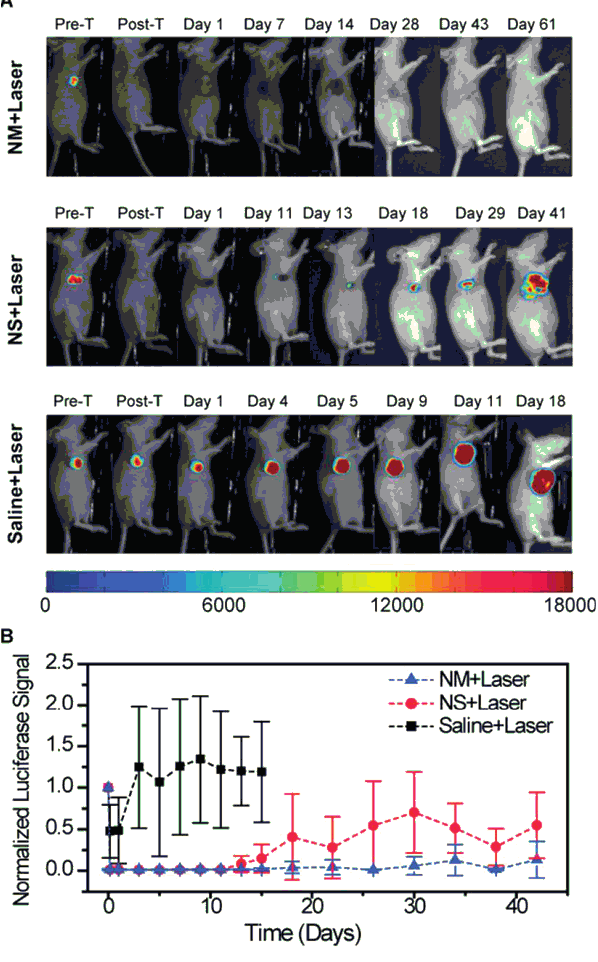
Figure 4. Evaluation of tumor response to photothermal therapy by bioluminescence imaging. The bioluminescence signal is generated only in living cancer cells as a result of luciferase activity. ( A ) Representative mice of each experimental group showing the luciferase activity in the tumor. The mice injected with nanomatryoshkas or nanoshells and treated with laser experienced loss of bioluminescence in the area illuminated by the laser as seen after therapy. Mice were euthanized when tumor volume reached 1,500 mm 3 or if the tumor persisted at 60 days after treatment. ( B ) Mean luciferase activity in the tumor with standard deviations. The luciferase signal was normalized to the signal before treatment (reprinted with permission from [49]; copyright (2014) American Chemical